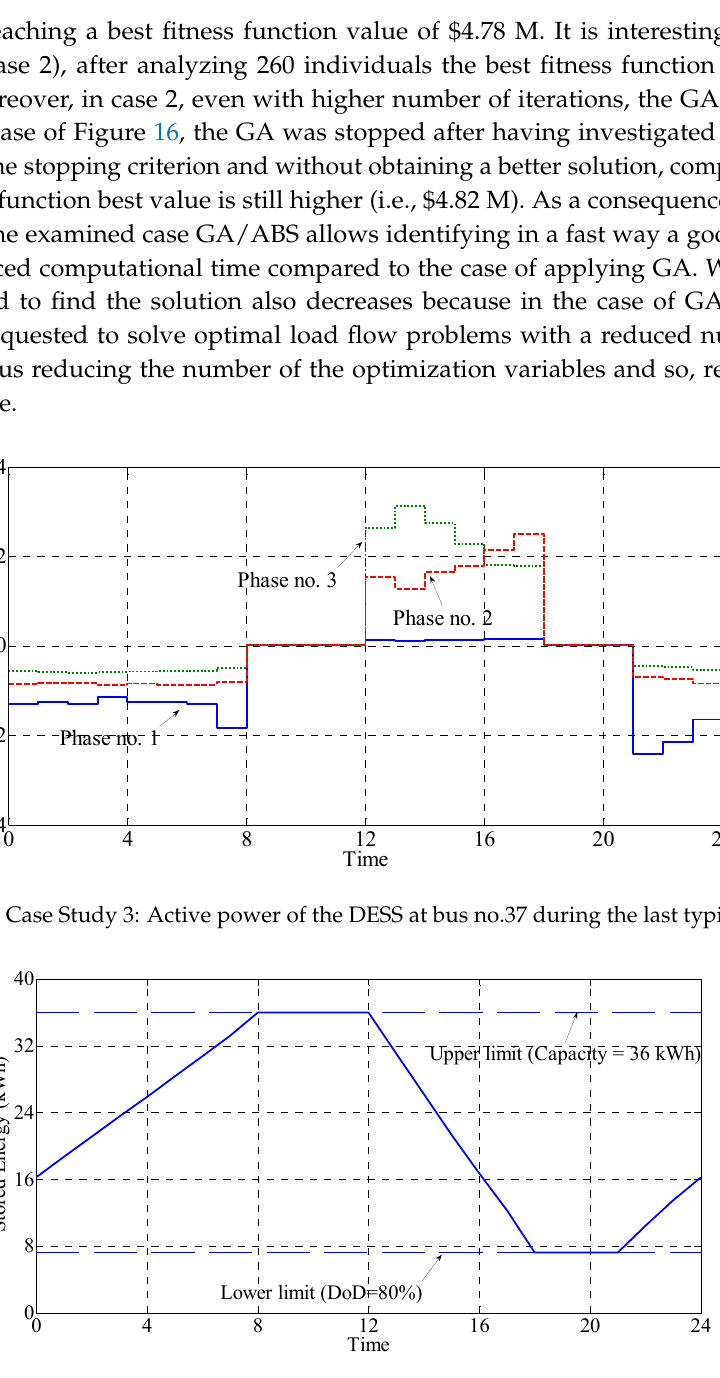
Figure 12. Case Study 3: Voltage magnitude of the residential feeder at hour 21.00 of the last typical day.